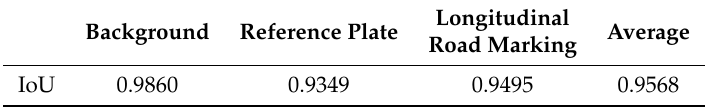
Table 3. Intersection-over-union (IoU) results obtained via the segmentation